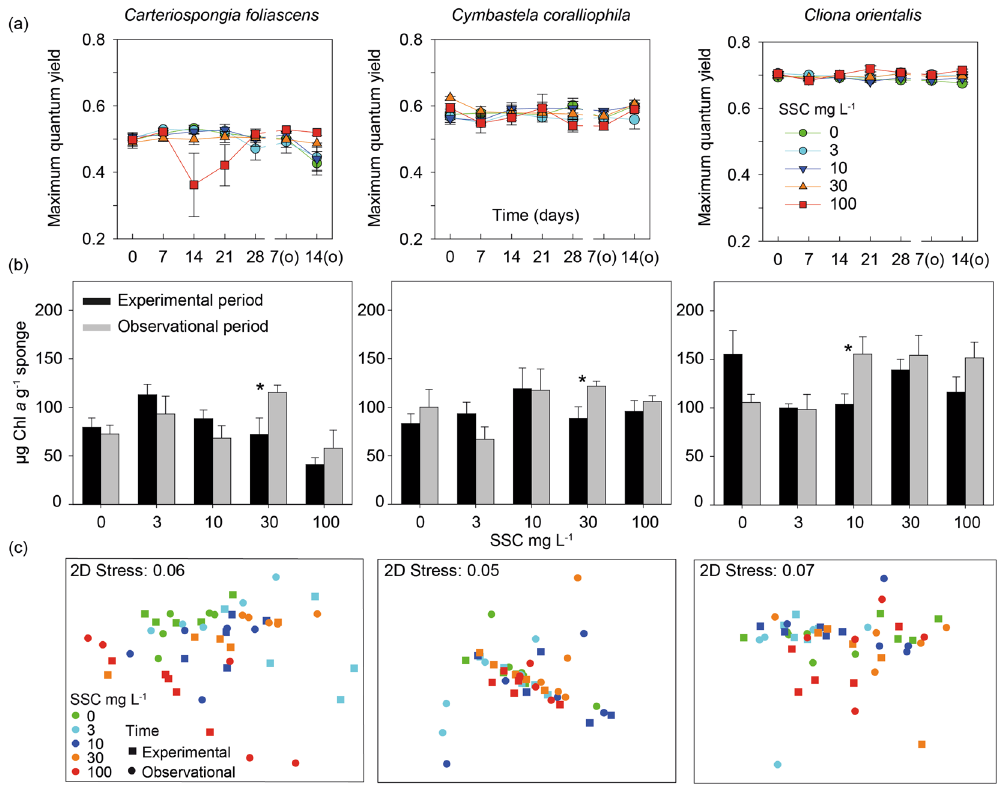
Figure 3. Response of the photosymbionts to elevated SSCs. ( a ) Mean values ( ± SE) of maximum quantum yield, ( b ) Mean values ( ± SE) of Chl a , and ( c ) Non-metric Multi-Dimensional Scaling (nMDS) of all photopigments retrieved by spectrophotometry, for the three phototrophic species and for all SSCs through the experimental phase and observational phase. Asterisks show statistically significant differences between the experimental and observational phase on b (t-tests: P <